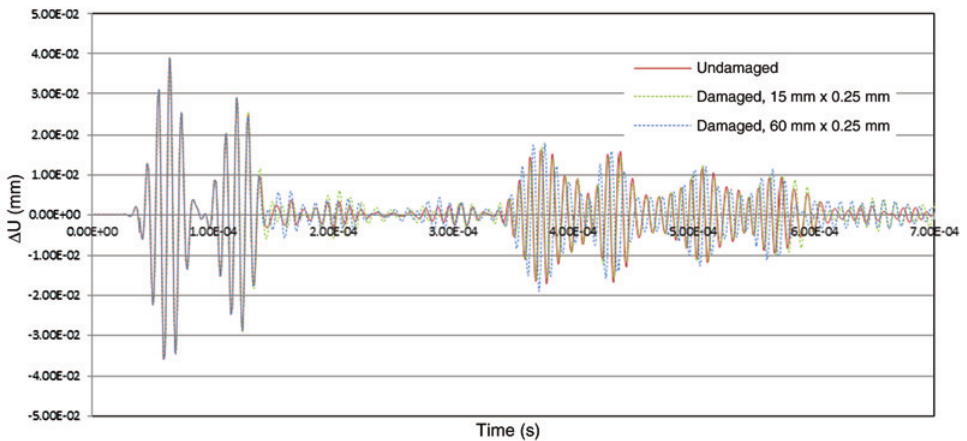
Figure 7: Strain-time history comparison.